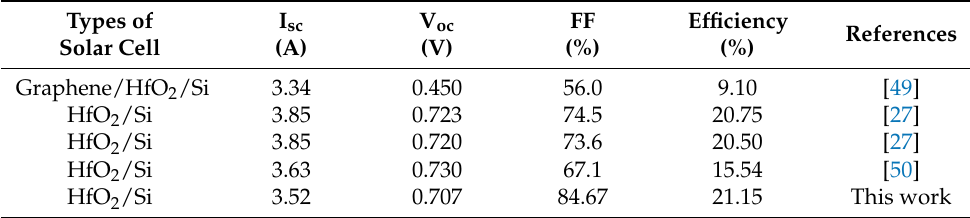
Table 3. A summary of reported PV parameters of HfO 2 ARC layer-based c-Si solar